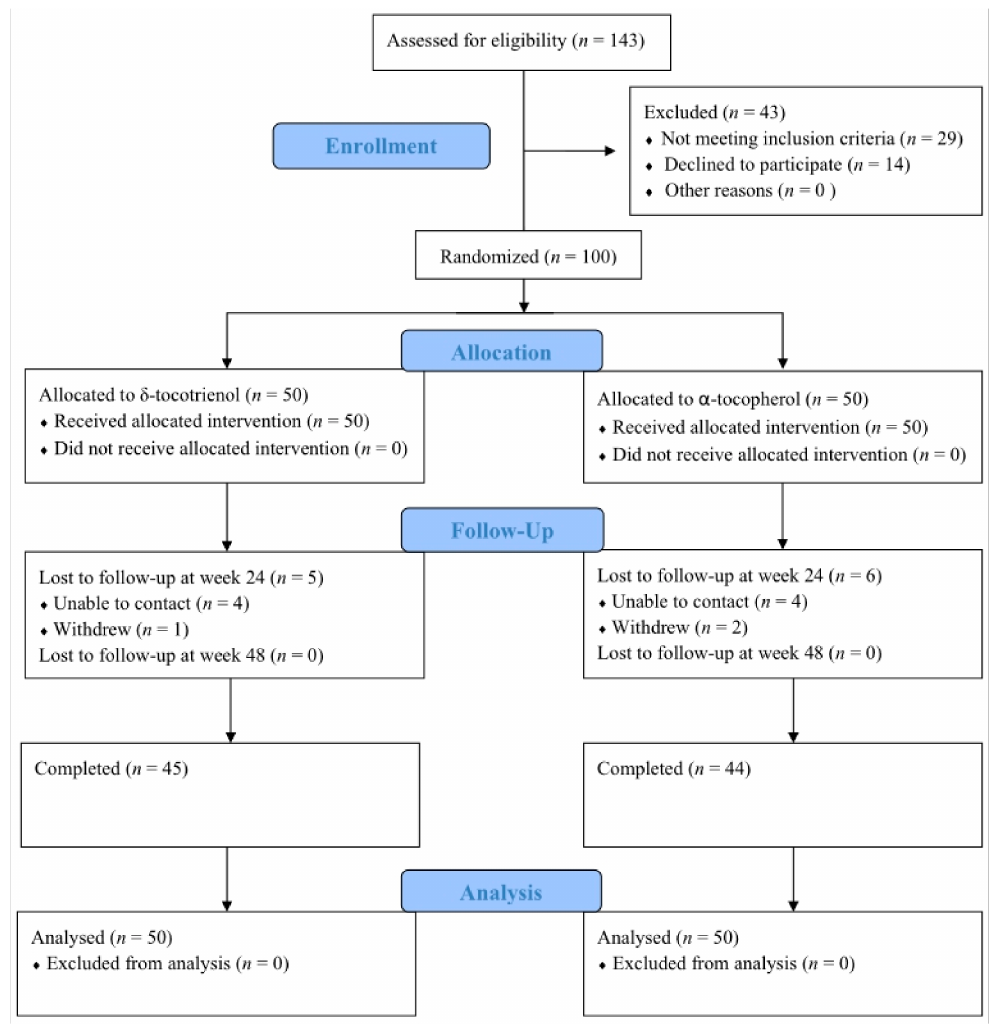
Figure 1. CONSORT flow